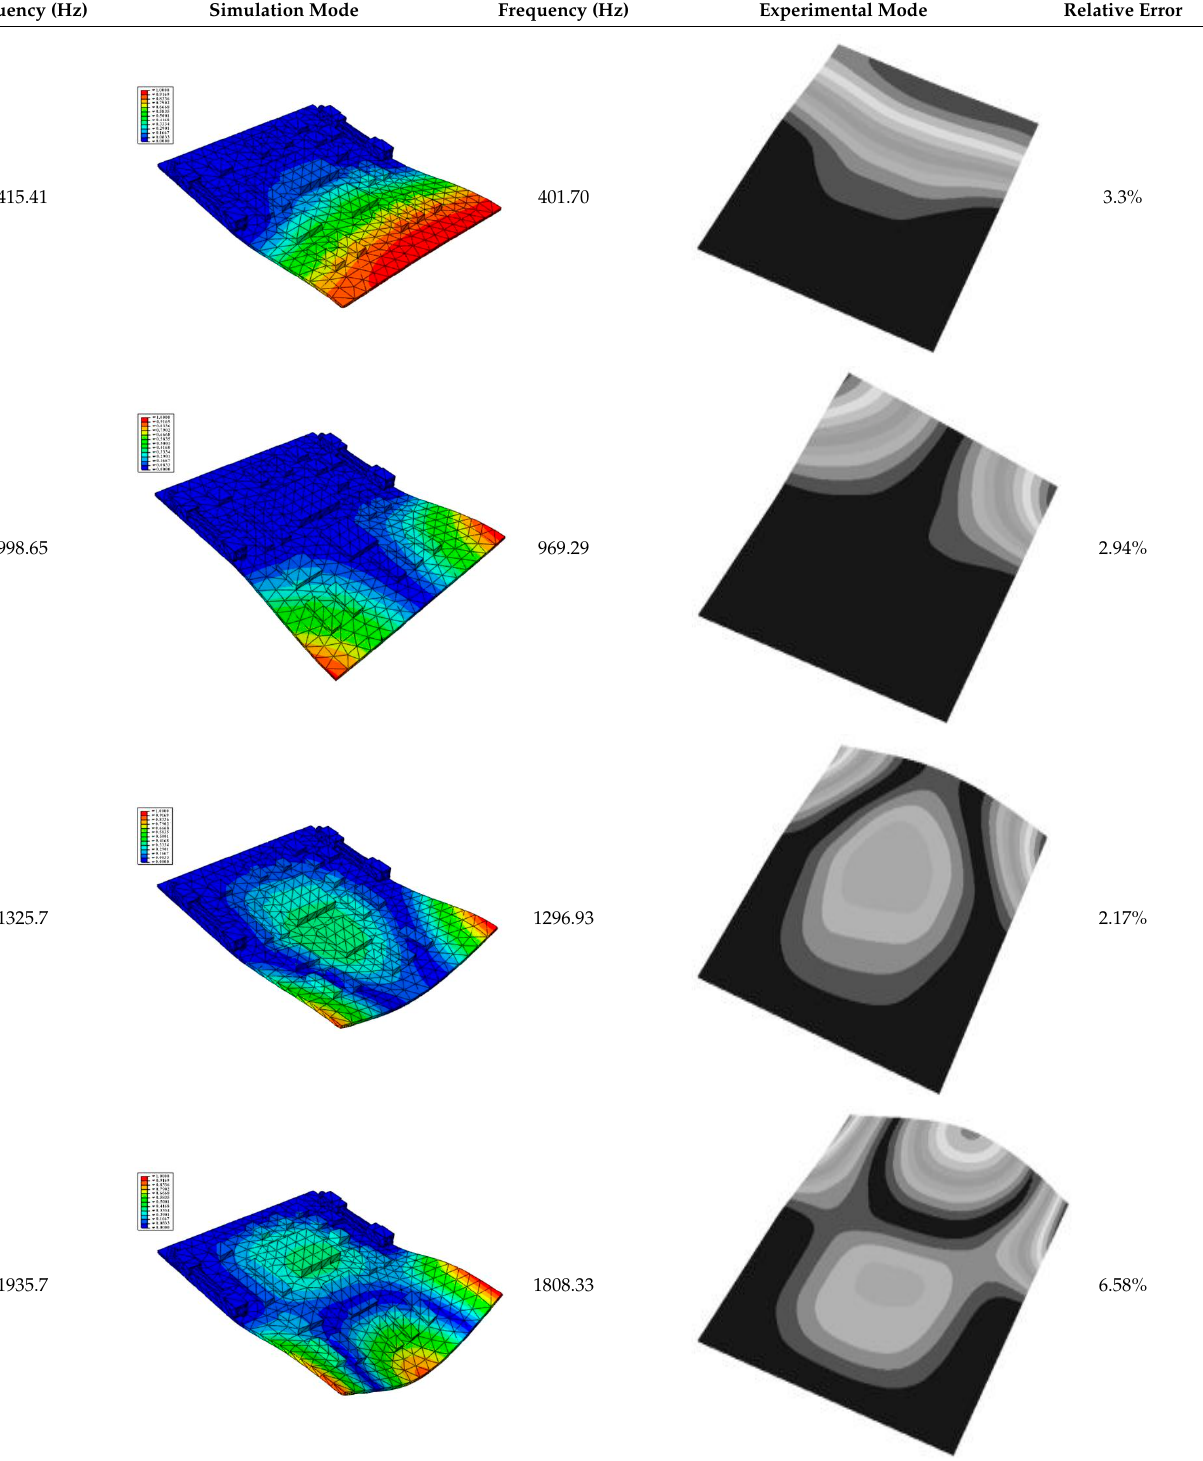
Table 3. Comparison between experiment and simulation of PCB mode analysis.